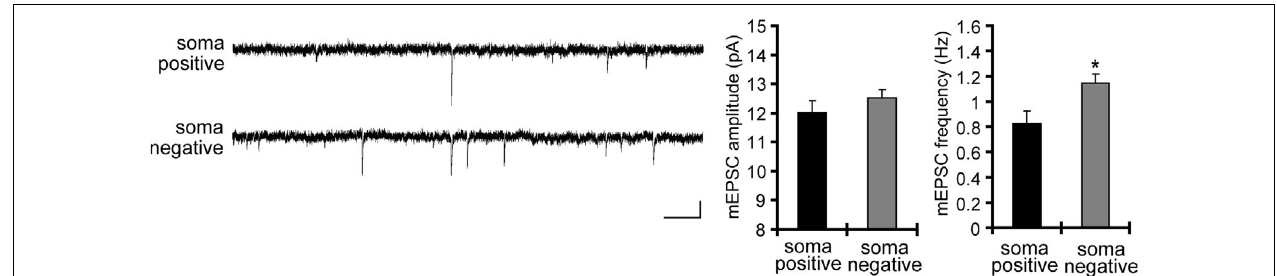
FIGURE 9 | A chronically applied external electric fi eld infl uences the frequency of mEPSCs. Representative mEPSCs recorded from the somata of CA1 pyramidal neurons after 4 h of external electric fi eld-application (10 mV/mm) in the presence of TTX (2 µM) + APV (50 µM). The electric fi eld-application